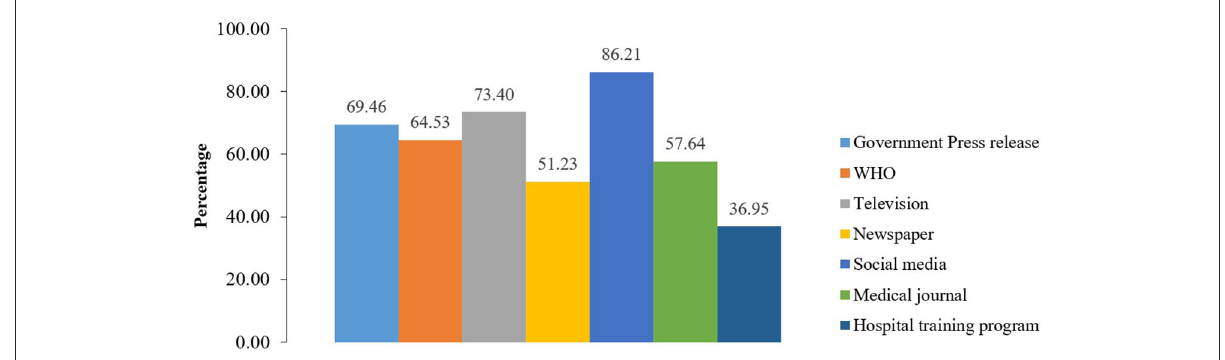
FIGURE1 Sources of information on COVID-19 disease among healthcare